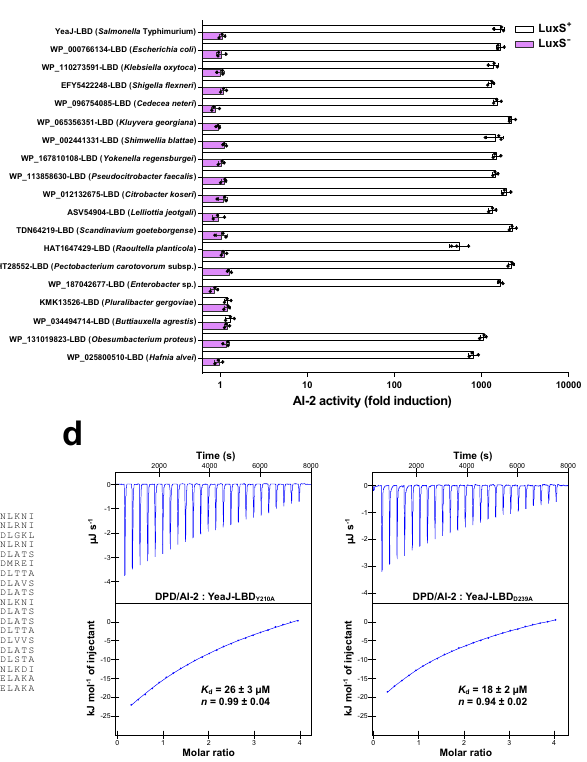
Fig. 2 | Widespread occurrence of GAPES1 domain-containing YeaJ homologs capableofsensingAI-2intheorder Enterobacterales .a Schematicillustratingthe predicteddomainorganizationofYeaJhomologs.Proteinsequenceswereanalyzed using hmmscan program against the Pfam 34.0 database. TM transmembrane domain, ECD extracytoplasmic domain, CD cytoplasmic domain. b GAPES1 domains from YeaJ homologs in bacterial species belonging to the Enterobacter- iaceae , Pectobacteriaceae , and Hafniaceae families are capable of retaining AI-2. GAPES1 domains from YeaJ homologs were expressed and puri fi ed as His 6 fusion proteins in a luxS + or luxS - E. coli strain. Bioluminescence in V. harveyi strain MM32 was measured following the addition of a buffer control or ligands released from the puri fi ed proteins upon denaturing by heating. YeaJ-LBD was used as a positive control. AI-2 activity is presented as mean±s.e.m. of three independent experi- ments. The NCBI accession numbers for YeaJ homologs are provided and the